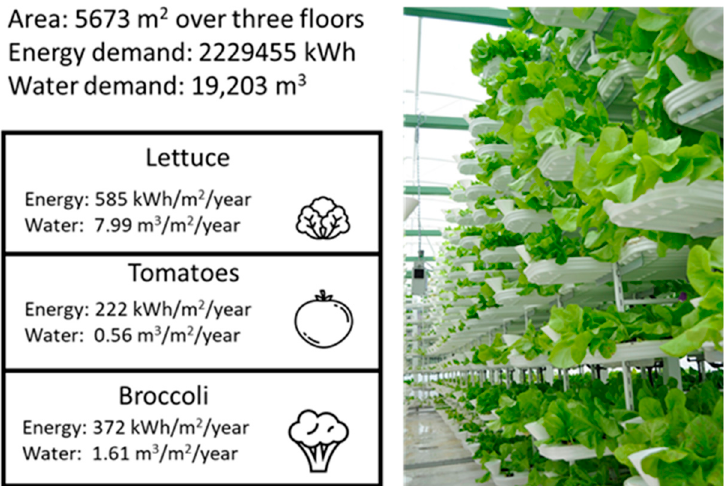
Figure 7. A closed agricultural environment (CEA) and the inputs needed to grow lettuce, tomatoes and broccoli. The inputs needed for a CEA that occupies three floors of a parking structure are listed. The photograph shows lettuce plants being grown in a vertically-stacked hydroponic system (VertiCrop System by Valcenteu, licensed under CC by 3.0).